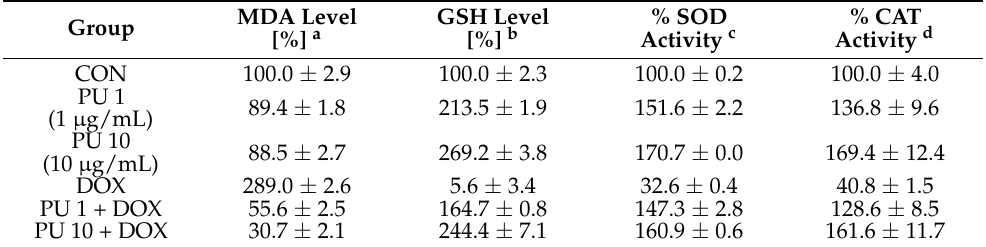
Table 9. The level of cardiotoxicity biomarkers in H9c2 cells treated with 1 µ M DOX in combination with ethanolic Phyllanthus urinaria L. (PU) extract in various combinations [25]. % SOD % CAT MDA Level GSH Level Group Activity c Activity d [%] a [%] b CON 100.0 ± 2.9 100.0 ± 2.3 100.0 ± 0.2